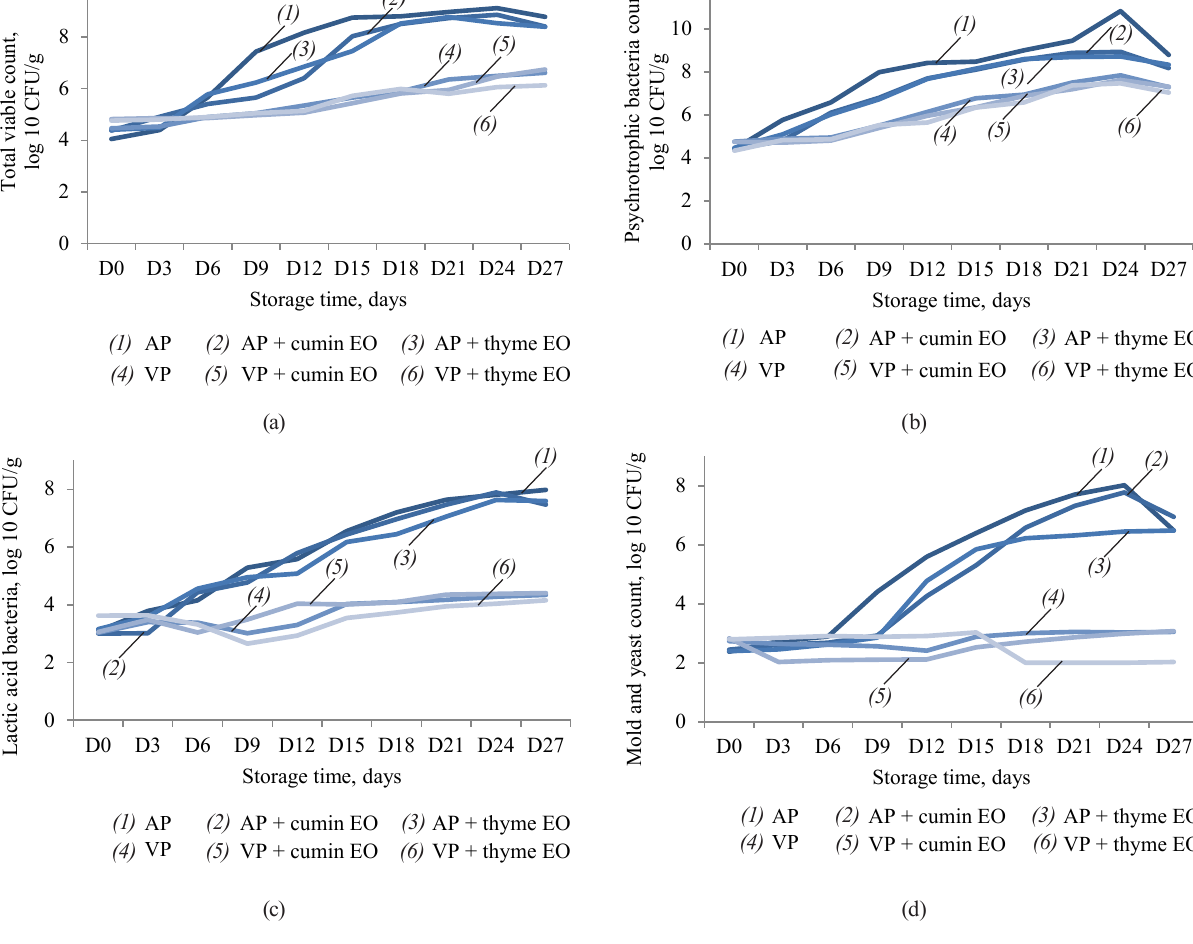
Figure 1 Effects of vacuum packaging (VP) and thyme and cumin essential oils on: (a) TVC, (b) psychrophilic count, (c) LAB, and (d) mold and yeast count in burgers stored at